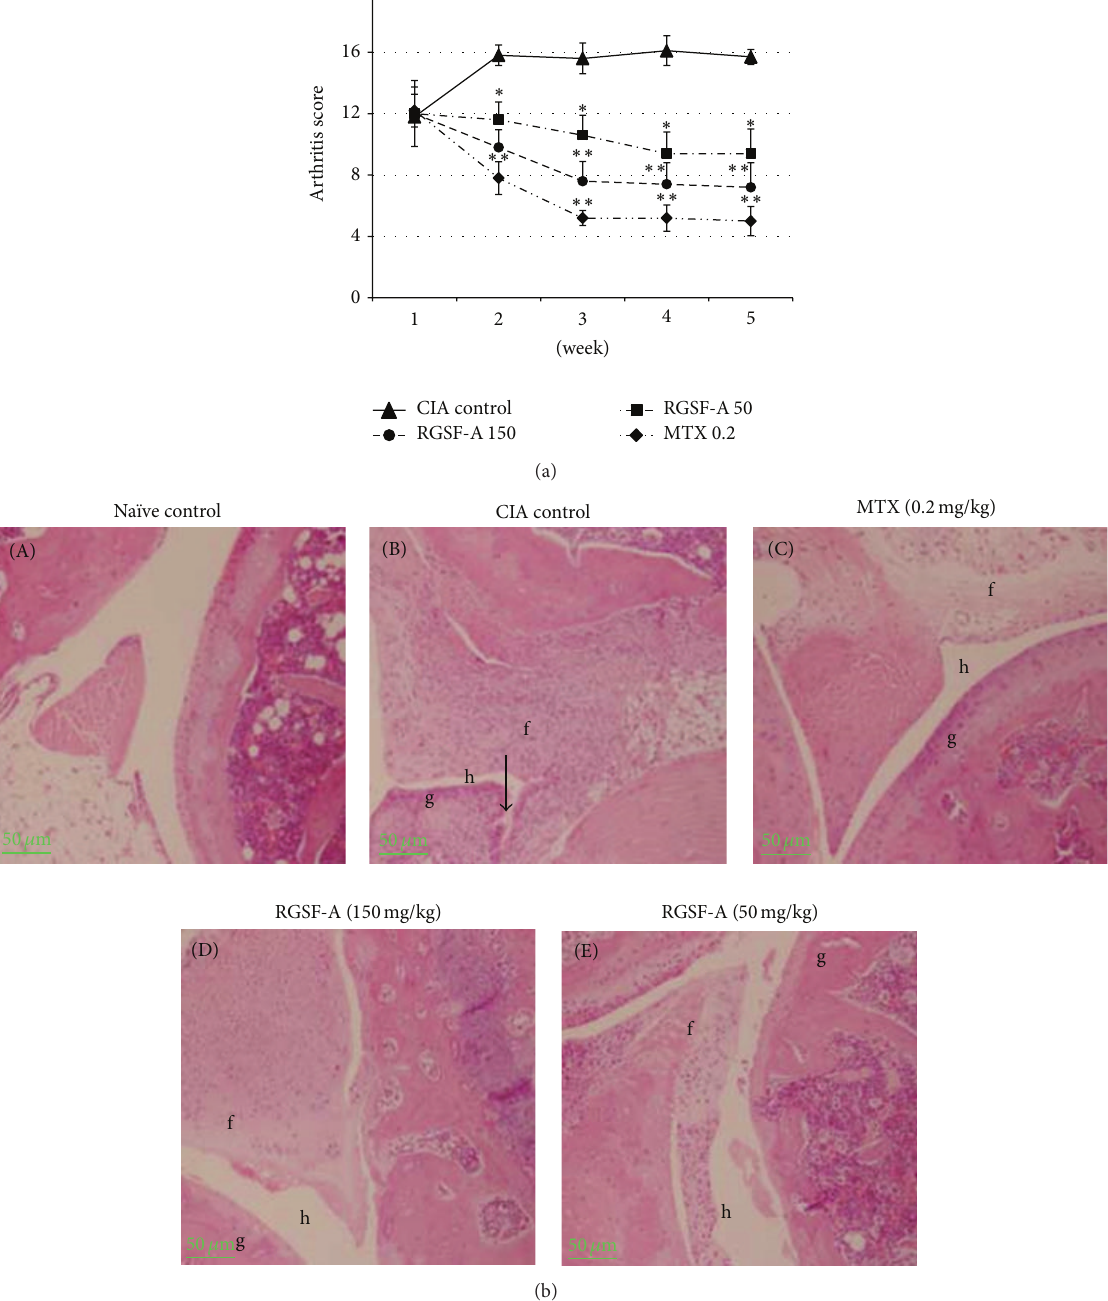
Figure 2: RGSF-A reduces the severity of clinical and histopathological signs of arthritis in CIA mice. (a) CIA was induced in DBA1J mice and 8 days after booster dose CIA mice injected either with phosphate-buffered saline (control) or 0.2 mg/kg methotrexate intraperitoneal or with oral dose of RGSF-A 50 or 150 mg/kg daily for 5 weeks. Arthritic score was assessed for the indicated weeks. (b) Histology of paw joints from CIA mice treated with vehicle, MTX, or RGSF-A. Paw joints were collected on day 54 after booster dose of na¨ıve unimmunized (A), vehicle CIA mice (B), 0.2 mg/kg MTX (C), 150mg/kg RGSF-A (D), or 50 mg/kg RGSF-A (E) treated CIA mice. Joints are formalin fixed, decalcified, sectioned, and stained with hematoxylin-eosin stains. Extensive leukocyte infiltration and synovial expansion into the articular surface are observed in vehicle-treated CIA mice (B), with massive inflammatory cell infiltration (f), synovial hyperplasia (g), narrowed articular space (j), and cartilage erosions (downward arrow). RGSF-A treated groups developed a less cellular infiltration (f) with a reduced hyperplasia (g) and clear articular space (h), which is comparable to MTX (D) groups. Histopathological images are magnified at 50x. Symbols in (a) represent mean value with SEM shown. ∗ 𝑃 < 0.05 and ∗∗ 𝑃 < 0.01 , as compared with vehicle treatment; 𝑛 = 6 for each